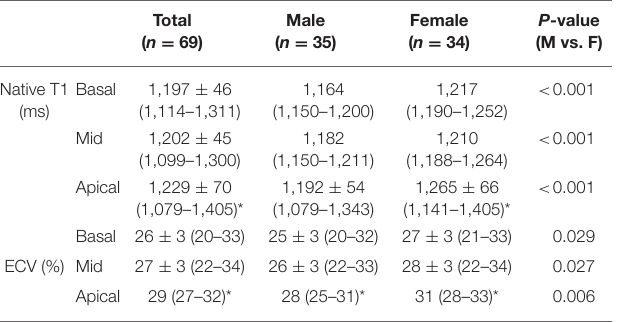
TABLE 4 | Myocardial native T1 and ECV at difference